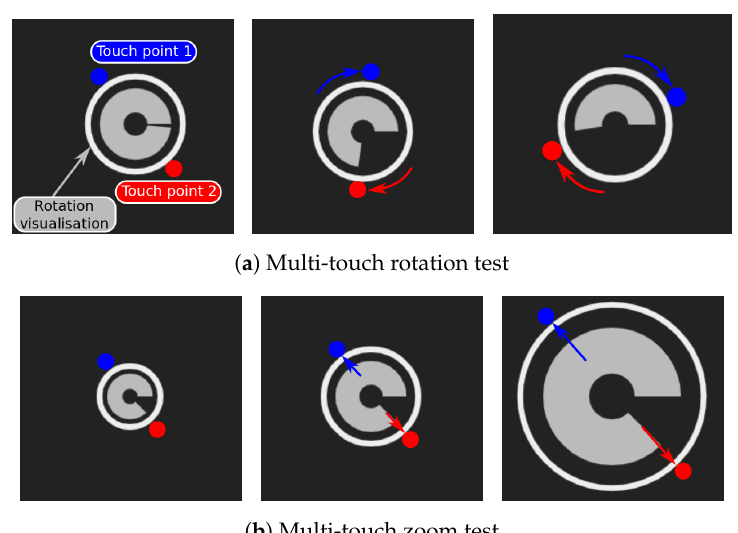
Figure 38. Tests of multi-touch interaction with the verifying web